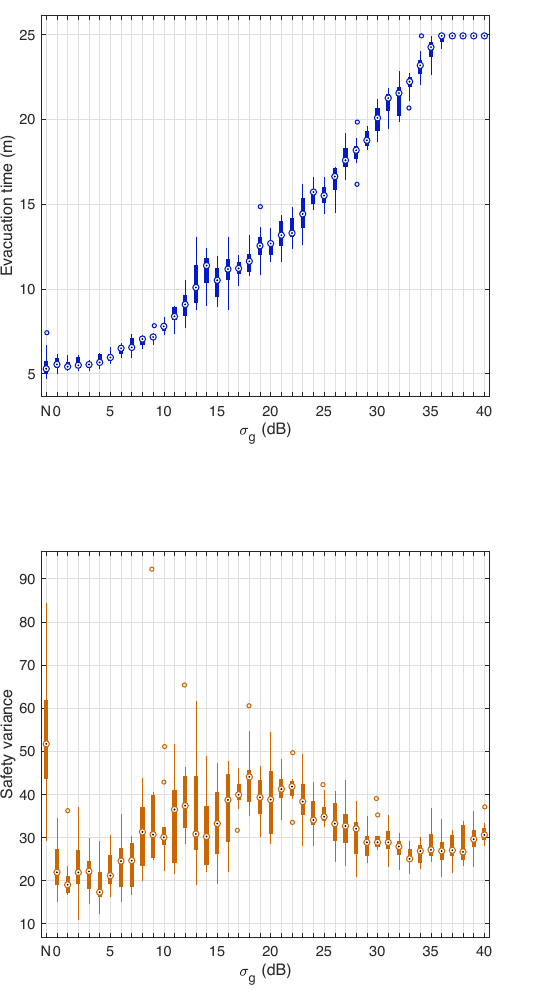
Figure 7. Sensitivity analysis of the positioning uncertainty in evacuation scenarios without external pedestrian flows. The box-plots on the first row show the sensitivity of evacuation time and average safety to standard deviation values σ g in the range 0 dB to 40 dB. The second-row plots show the sensitivity of safety variance and the number of decision changes to the standard deviation values σ g . In the four box-plots, σ g = N represents an evacuation scenario in which pedestrians do not use